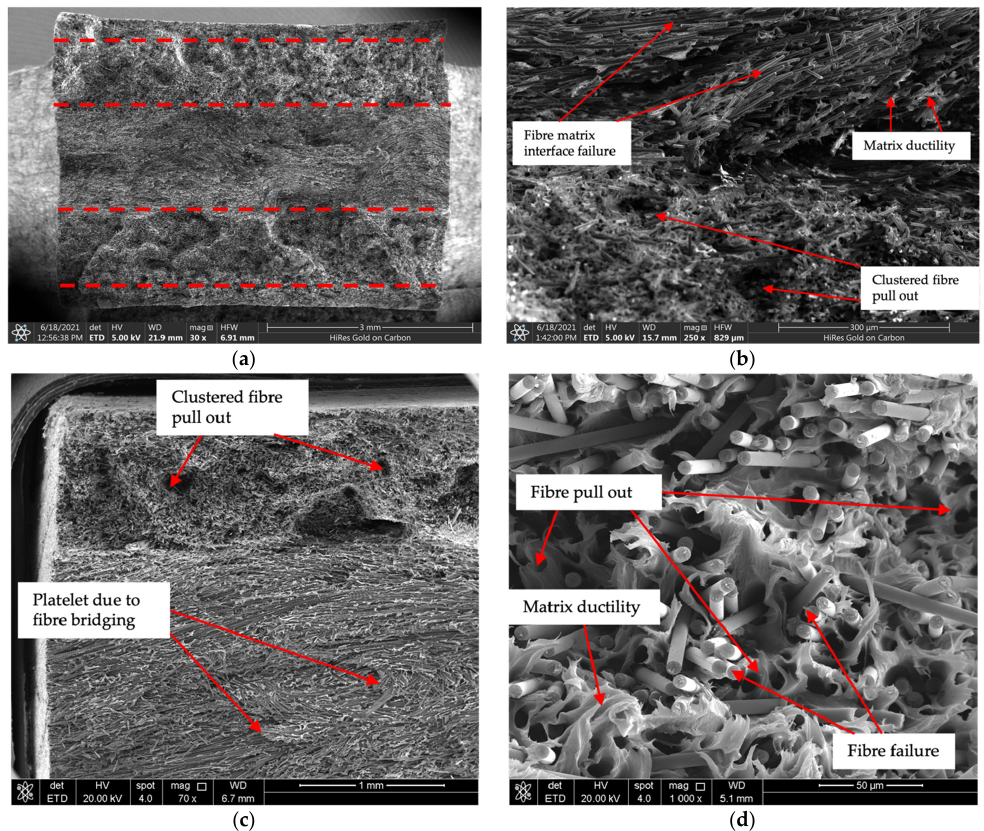
Figure 8. Fatigue fracture surfaces at 120 °C under tension–tension fatigue loading R = 0.1 ( a ) SCF N f = 277,212, red dashed lines separate skin-shell-core–shell-skin fibre orientation ( b ) SCF N f = 16,138; ( c ) LCF N f = 23,021; ( d ) LCF N f =